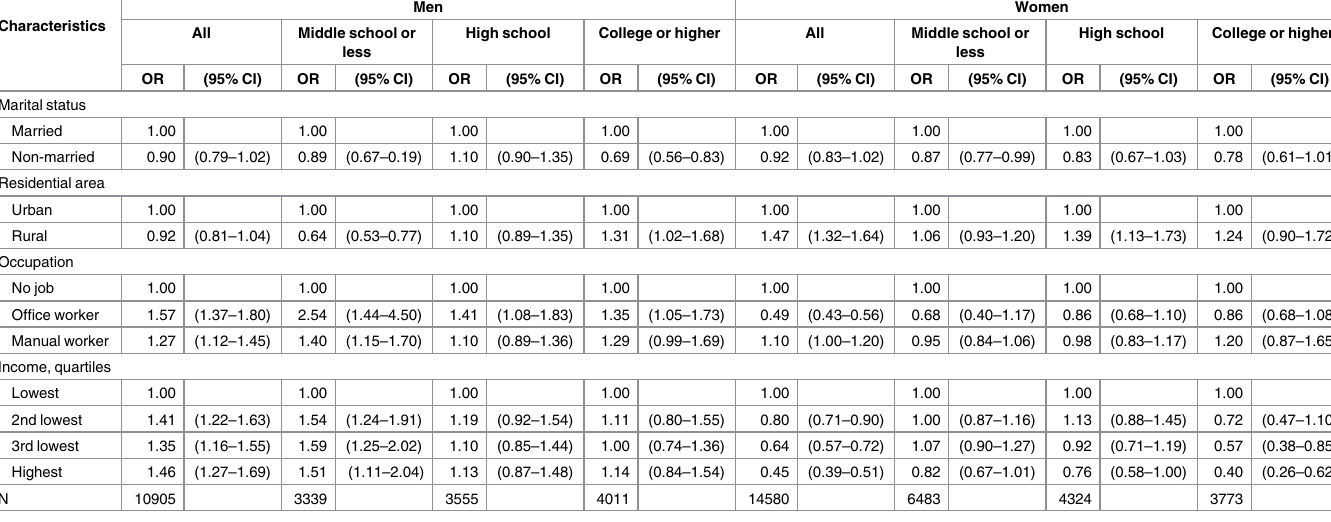
Table 3. Adjusted odds ratios (and their 95% CIs) of obesity according to socioeconomic status indicators with and without being stratified by education level for each sex.